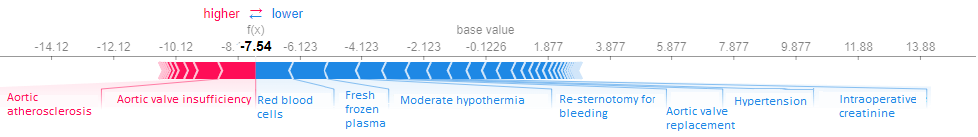
Figure 3. The example of a single patient’s prediction.